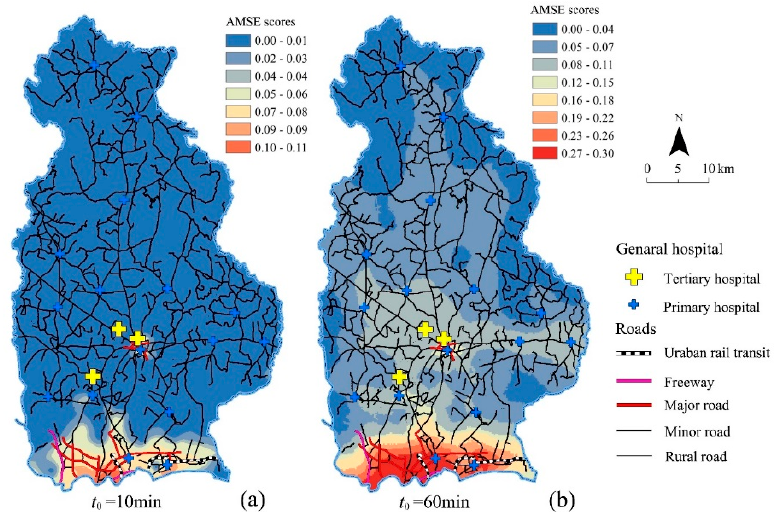
Figure 10. AMSE scores and topographic map of Huangpi district. ( a ) shows the AMSE scores at t 0 = 10 min; ( b ) shows the AMSE scores at t 0 = 60 min.